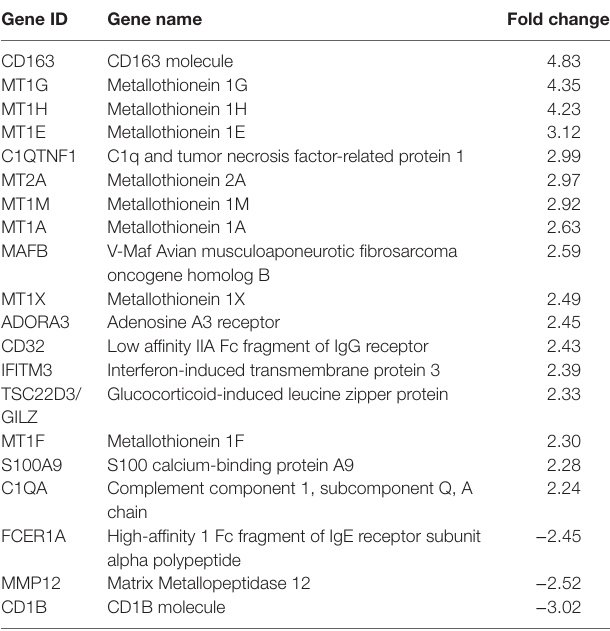
TaBle 1 | Top 20 of most regulated genes by treatment of monocyte-derived dendritic cells with dexamethasone and monophosphoryl lipid A.